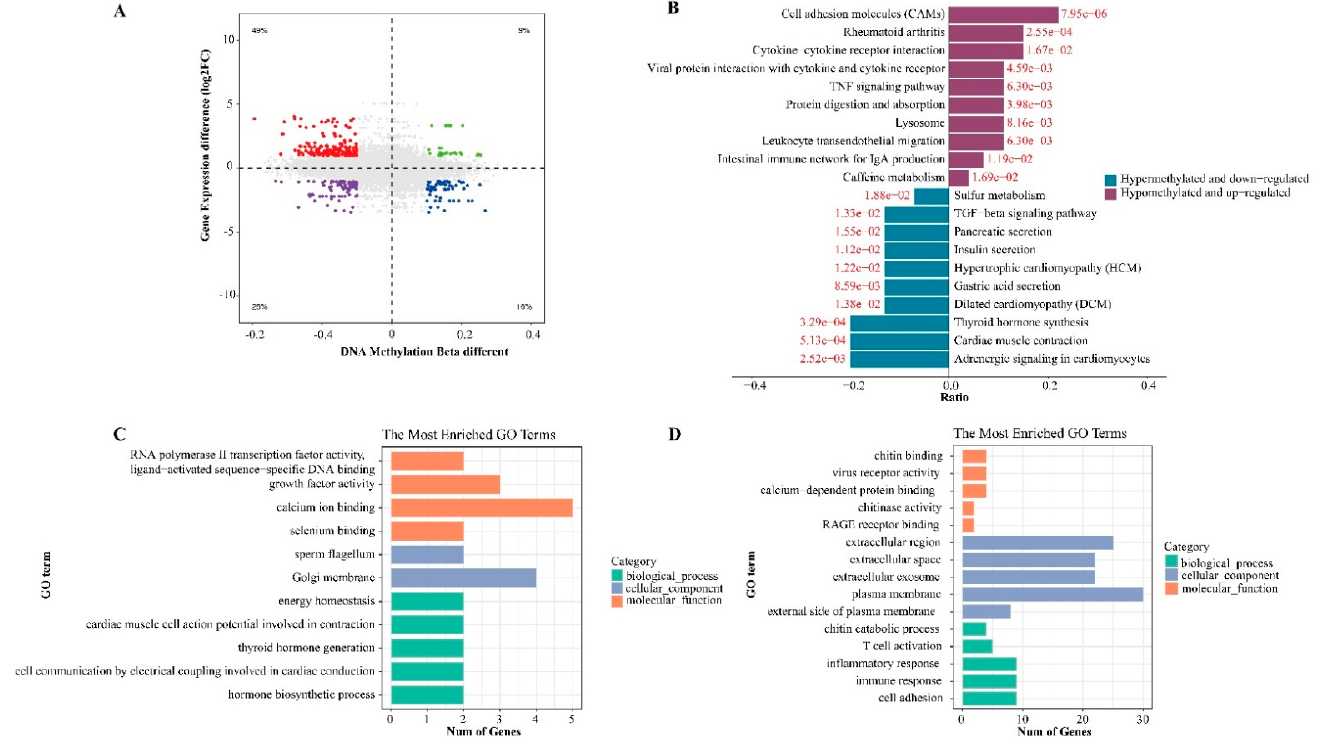
Figure 3. Selection of methylation-driven genes in thyroid papillary carcinoma. ( A ) Volcano plot showing the integrative analysis of the methylation profile and transcriptome profile of PTC. Red dots represent hypomethylated and highly expressed genes, and blue dots represent hypermethylated and lowly expressed genes. ( B , C ) The top 10 KEGG enrichment analysis results of hypermethylated and down-regulated genes and hypomethylated and up-regulated genes. ( D ) The top 5 GO enrichment analysis results of hypermethylated and down-regulated genes and hypomethylated and up-regulated genes.